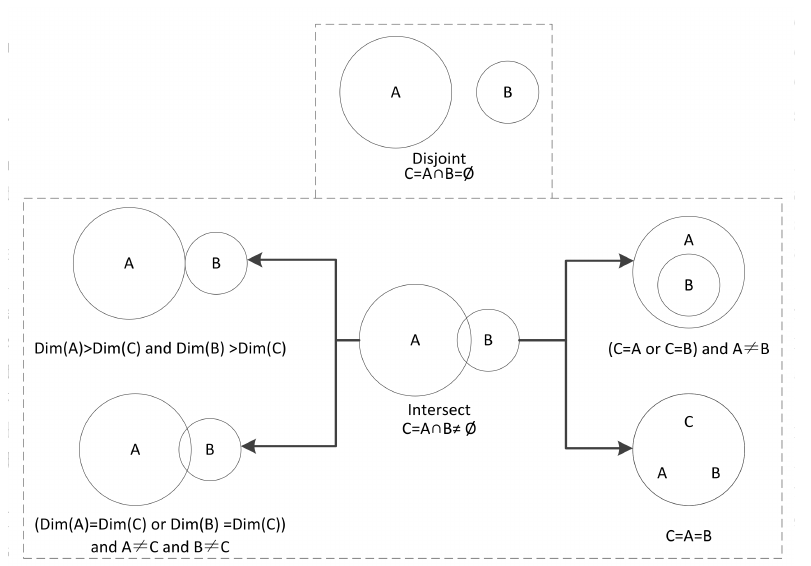
Figure 4. Classes of topological relations for spatial